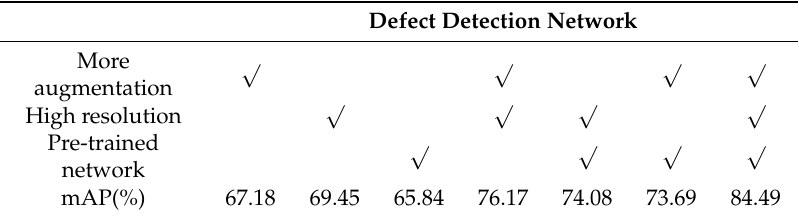
Table 10. Summary of influencing factors.